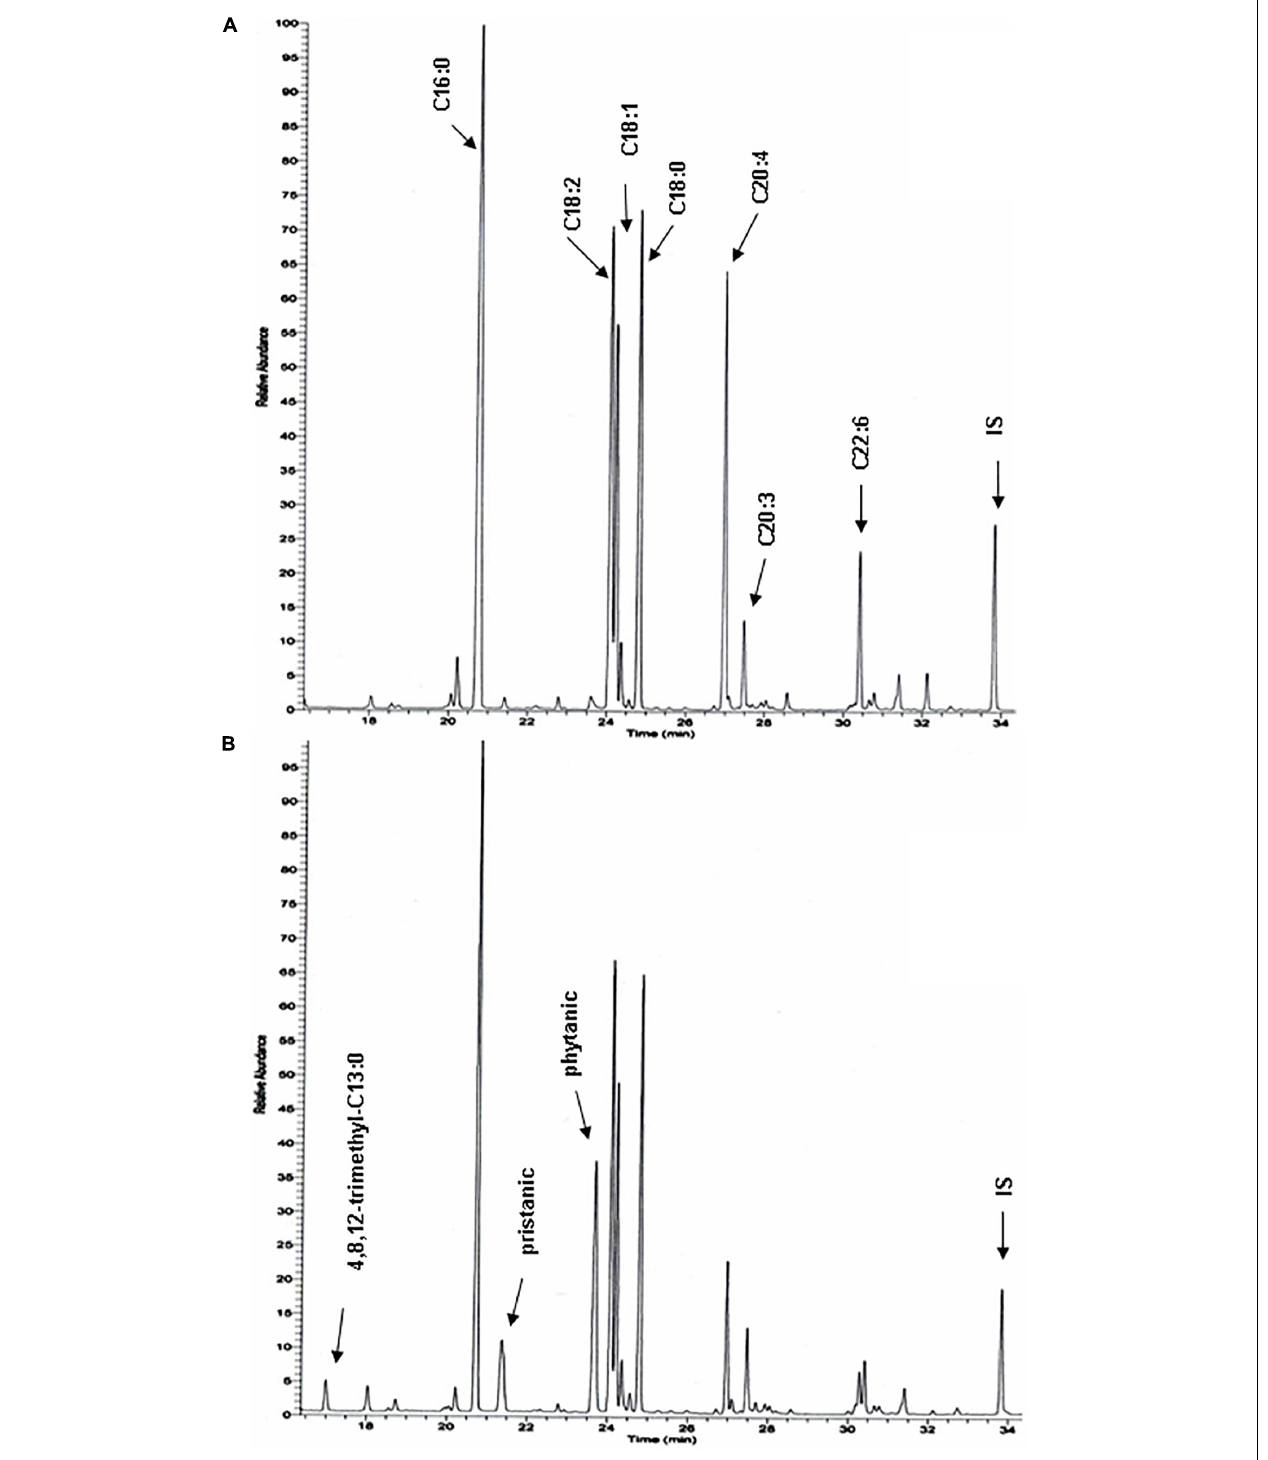
FIGURE 7 | Total hepatic fatty acid profiles of phytol challenged PMP34 knockout mice. GC-MS profiles of tert-butyldimethylsilyl esters prepared from total lipid extracts from livers of age-matched male wild type (A) and knockout (B) mice fed phytol diet. A portion of the chromatogram (15-35 min) is shown. Major peaks are labeled for the wild type sample (A) , and extra peaks appearing in the knockout sample are indicated in panel B. Using a temperature program better suited for separation of medium chain fatty acids, 2,6,10-trimethylundecanoic acid is also seen in the KO profiles (not shown) (IS, internal standard; tricosanoic acid, C23:0).